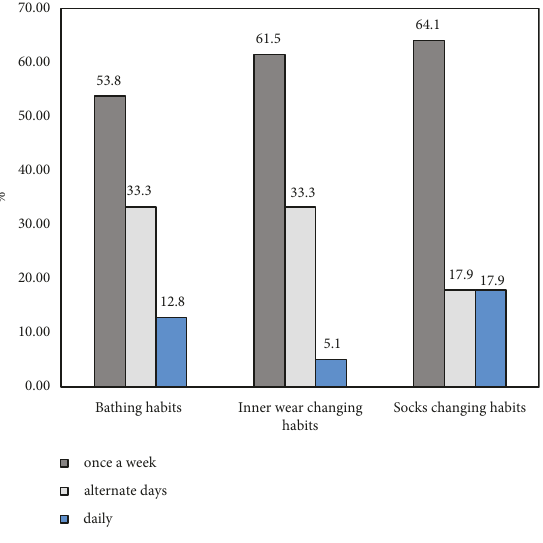
Figure 7: Hygienic status of positive cases. Table 6: Binary logistic regression analysis of risk factors associated with increased fungal infection. Risk factors associated with increased fungal